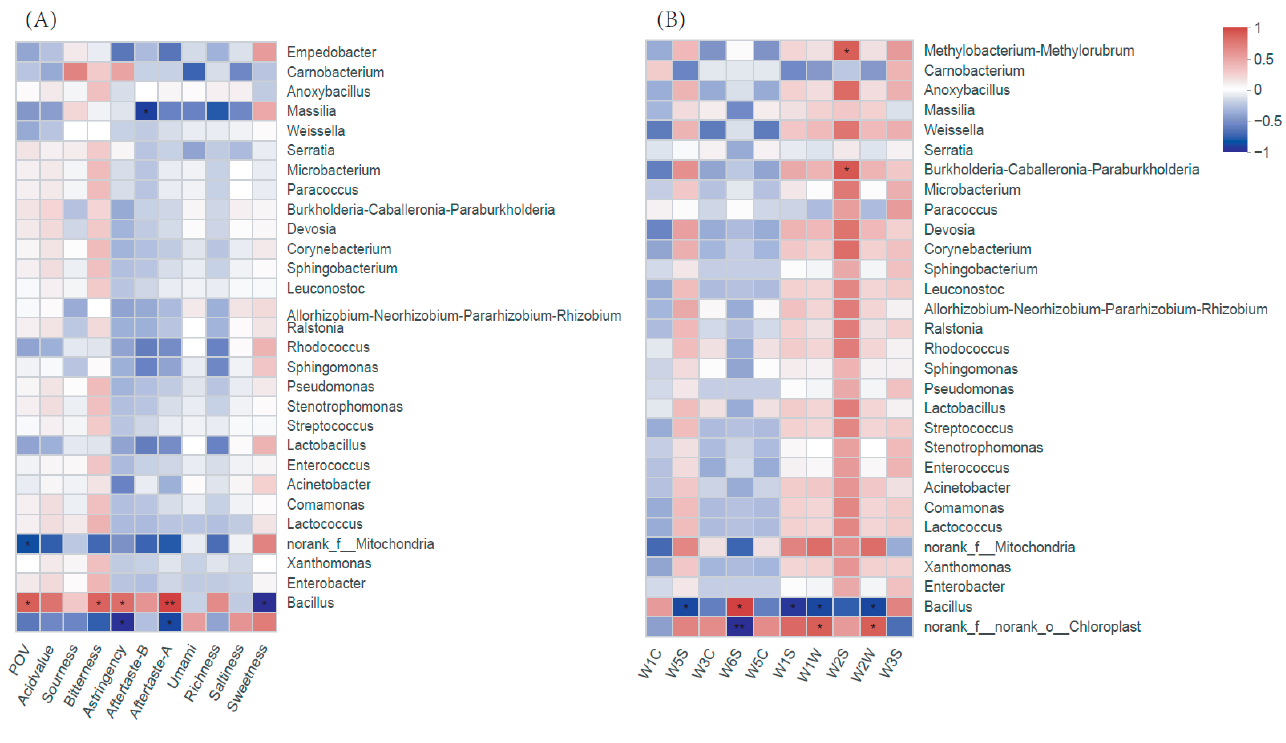
Figure 5. Correlation analysis on the physicochemical, taste ( A ), flavour indices ( B ), and bacterial composition of hotpot sauce. Note: “*“ indicated p ≤ 0.05, “**” indicated 0.001 ≤ p ≤